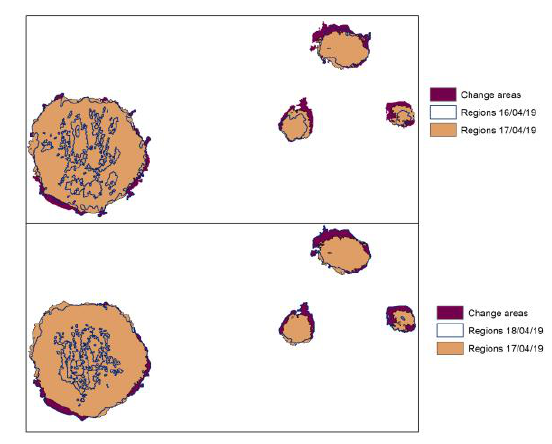
Figure 6 Visualization of regions on dates 16/04, 17/04 (top), 18/04, 17/04 (bottom), and their change